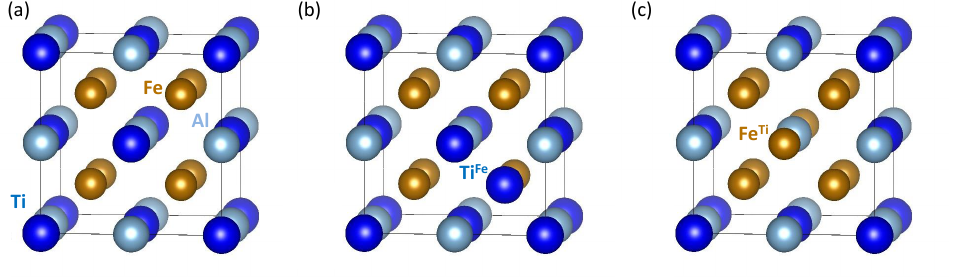
Figure 1. ( a ) Schematic visualization of the cube-shaped 16-atom Fe 2 AlTi supercell used in our calculations. Two types of substituted states (discussed below) when either ( b ) Ti replaces Fe or ( c ) Fe replaces Ti. The FSM approach [31,41–47] allows the total magnetic moment of a computational supercell to be fixed at a specific value. The local magnetic moments are free to change (given the overall